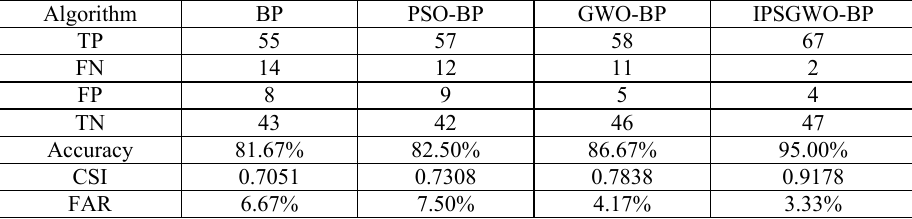
Table 4. Prediction accuracy of each algorithm on thunderstorm disaster data